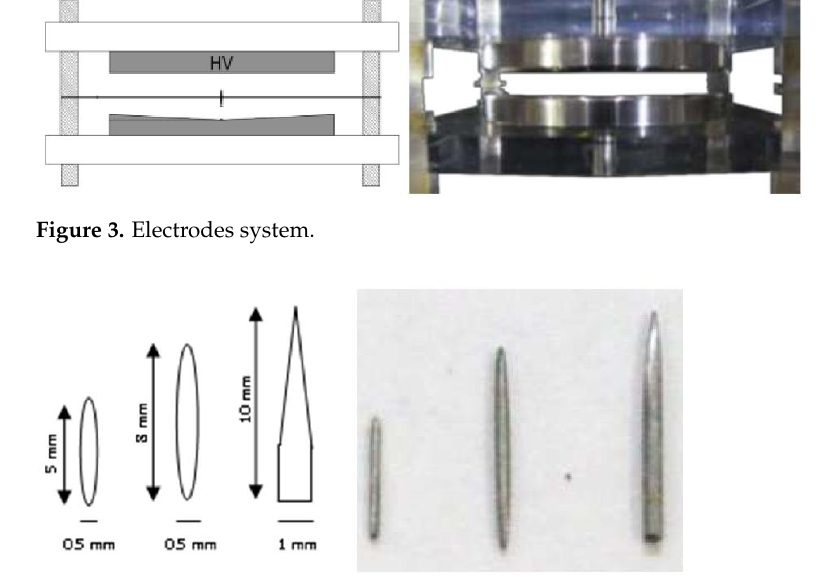
Figure 4. Shape and Size of Metallic particles.